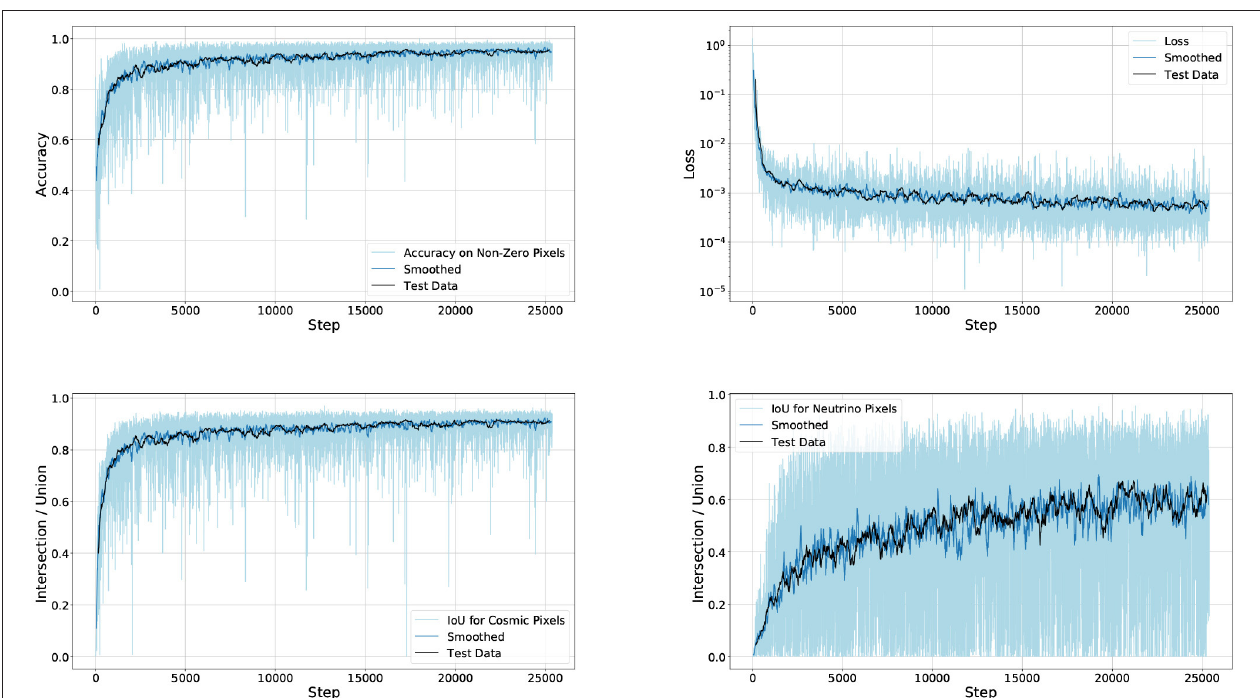
FIGURE 8 | The training progression of the Multiplane UResNet model, trained for 25 k iterations. The light blue curve is the training performance at each step, overlaid with a smoothed representation of the same data, and a smoothed representation of the test set.